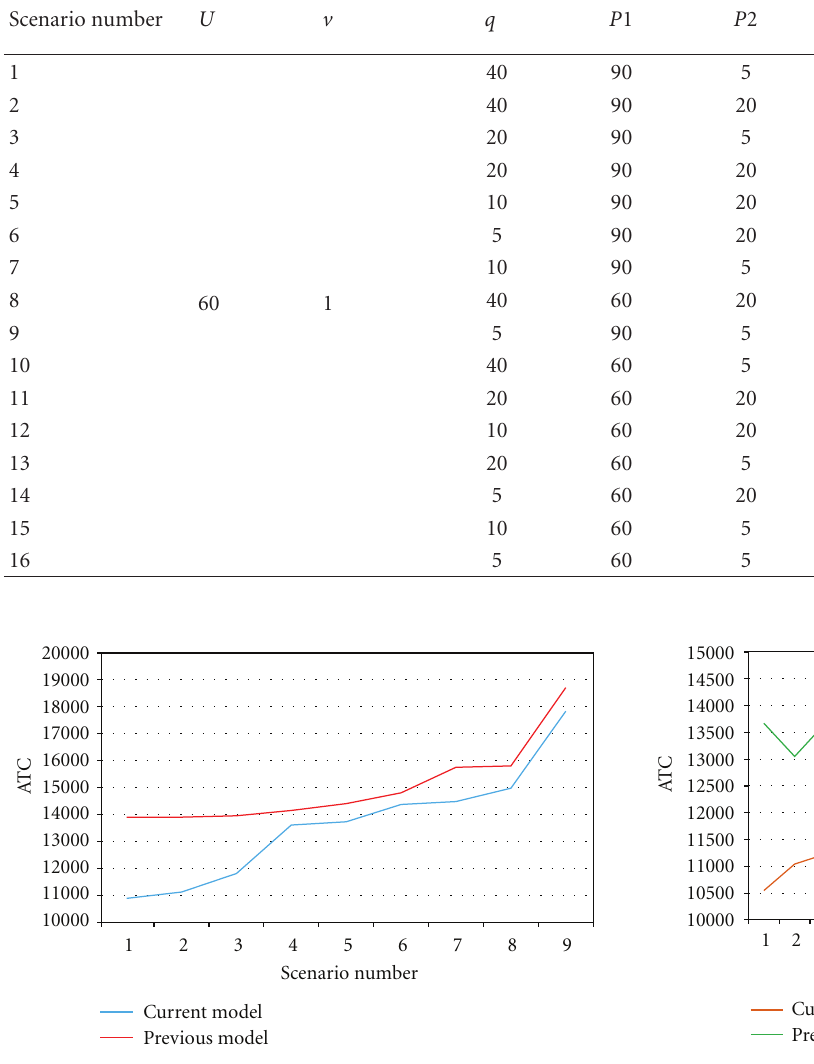
Figure 10: Compare current model with previous study under di ff erent scenarios of v and u .